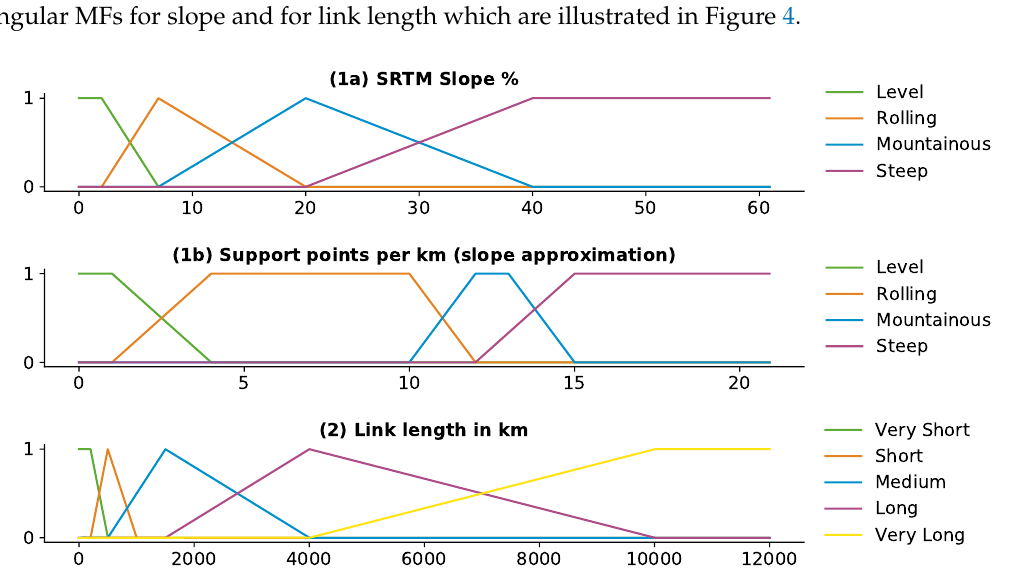
Figure 4. MF of the parameters ( 1a ) Shuttle Radar Topography Mission (SRTM) slope %, ( 1b ) support points per kilometer and ( 2 ) link